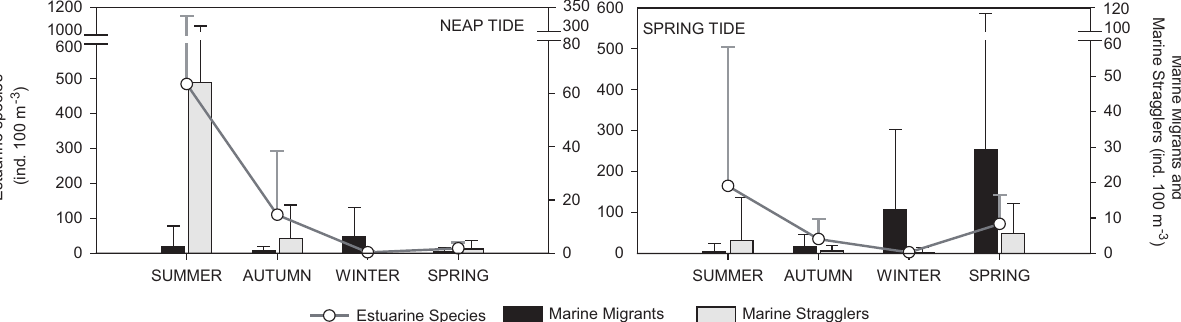
Fig. 4 . – Seasonal larval fish densities (mean+SD, ind. 100 m -3 ) of the three main ecological guilds at each lunar-tide cycle. Estuarine species (left axis); Marine Migrant and Marine Stragglers (right axis). Table 2. – Mean density (ind. 100 m -3 ) of the main ichthyoplankton species recorded in Mondego estuary for each season, lunar-tide cycle (neap and spring) and tide cycle (ebb and flood) and results from 2-way univariate PERMANOVA (pseudo-F values) analysis.